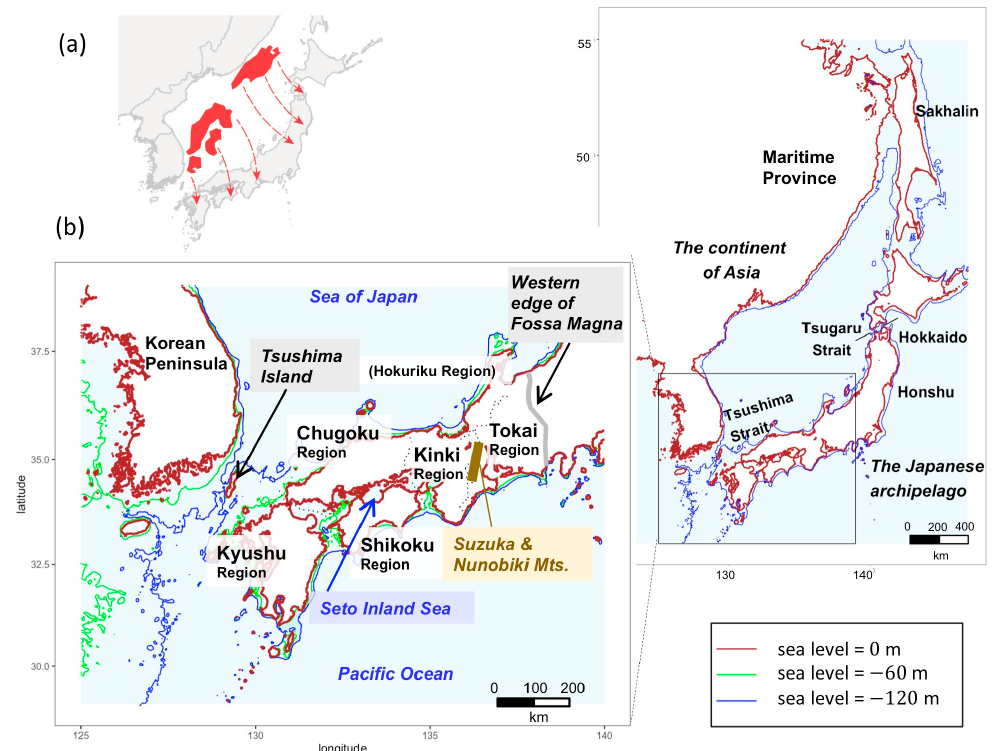
Figure 2. History of the Japanese Archipelago and study area. ( a ) Paleogeography of the Japanese archipelago inferred from geophysical information [12]. The red arrows indicate the movement of the land masses from the original position. ( b ) Study area map. An inferred map of the Far East during the last glacial period. The Seto Inland Sea, surrounded by Kyushu, Chugoku, Shikoku, and Kinki regions, with an average water depth of 38 m. Green and blue lines represent 60 and 120 m bottom depths [13,14], respectively, and allow for inferences to be made about coastal lines at times of lowered sea level.